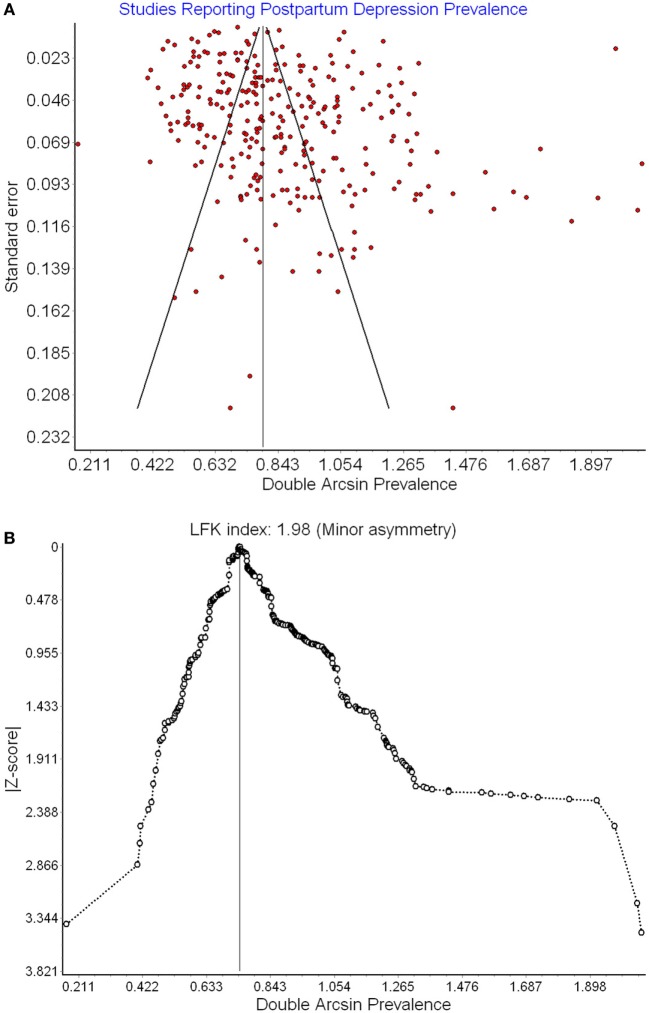
Funnel plot (A) and Doi plot (B) of postpartum depression (PPD) prevalence as a function of prevalence estimate SE.